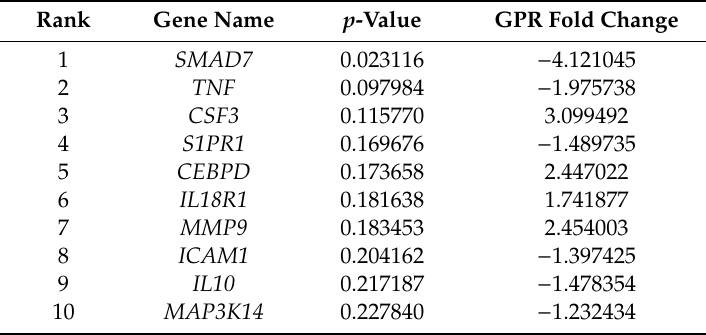
Table 2. Top ten* di ff erentially expressed genes in healthy donors versus RRMS patients with respect to Th17-related genes included in the Human T helper 17 (Th17) 96 StellARray qPCR